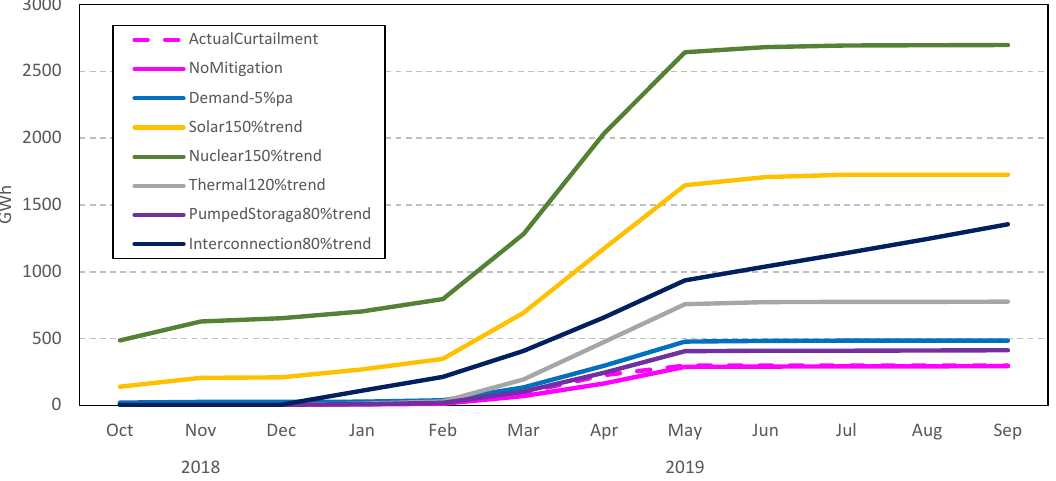
Figure 12. Cumulative sum of actual curtailment and forecast scenarios that increased curtailment from October 2018 to September 2019.